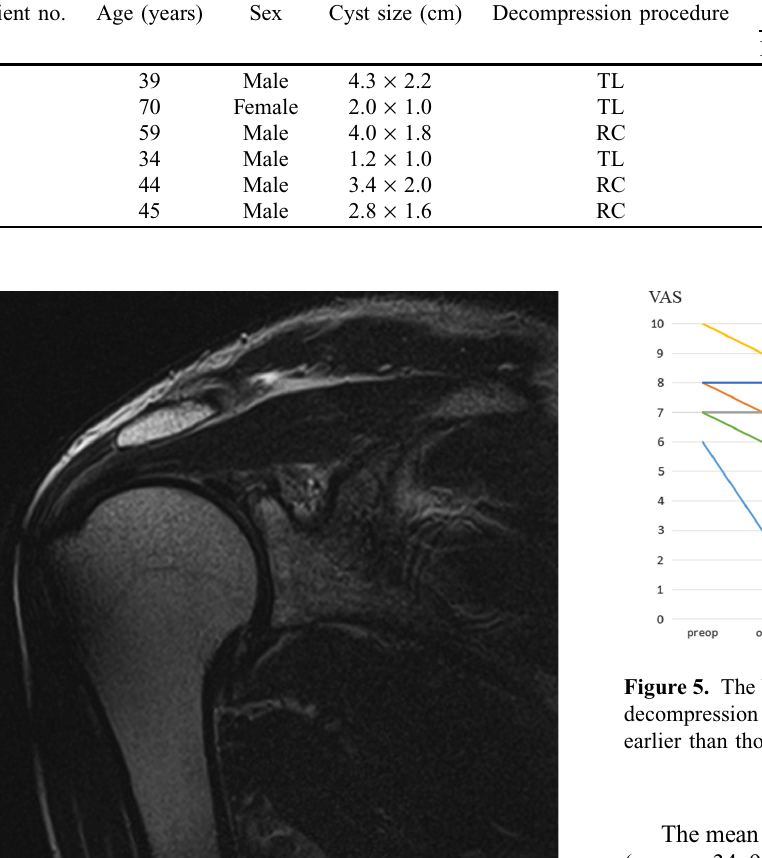
Figure 4. Postoperative T2-weighted MRI scan demonstrating disappearance of the spinoglenoid cyst.